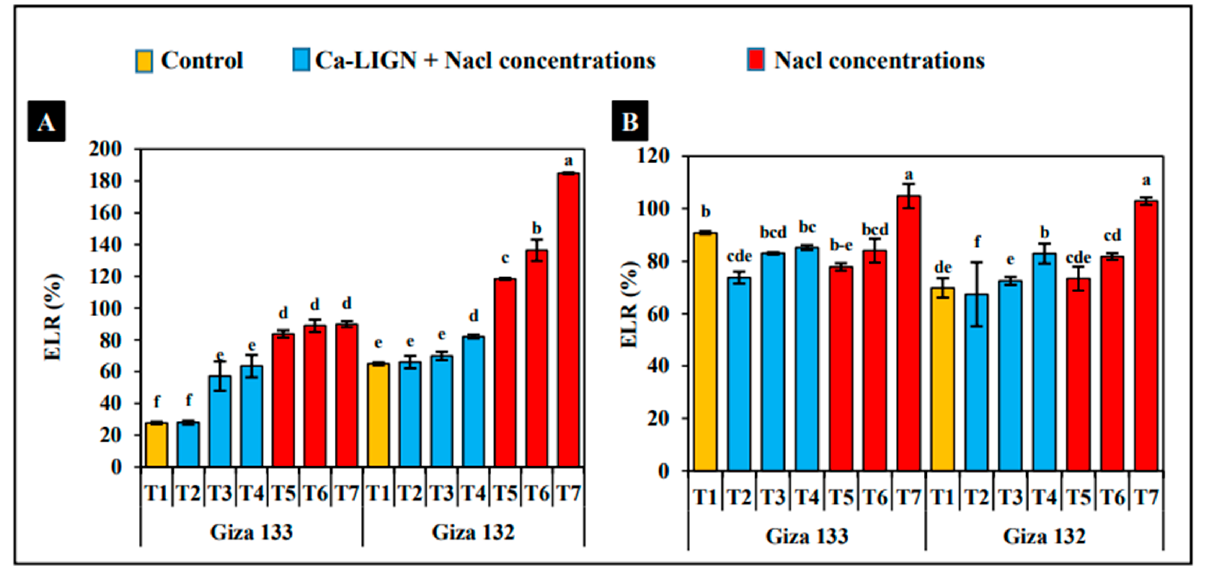
Figure 5. Effect of different treatments: (T1) control, (T2) 100 mM NaCl + Ca-LIGNO, (T3) 200 mM NaCl + Ca-LIGNO, (T4) 300 mM NaCl + Ca-LIGNO, (T5) 100 mM NaCl, (T6) 200 mM NaCl, and (T7) 300 mM NaCl on the average electrolyte leakage ratio (ELR) in ( A ) leaf and ( B ) root of the two barley cultivars, Giza133 and Giza132, during two seasons, 2019/2020 and 2020/2021. Data represent the mean ± SE (n = 4). The same letter indicates no significant difference ( p ≤ 0.05).